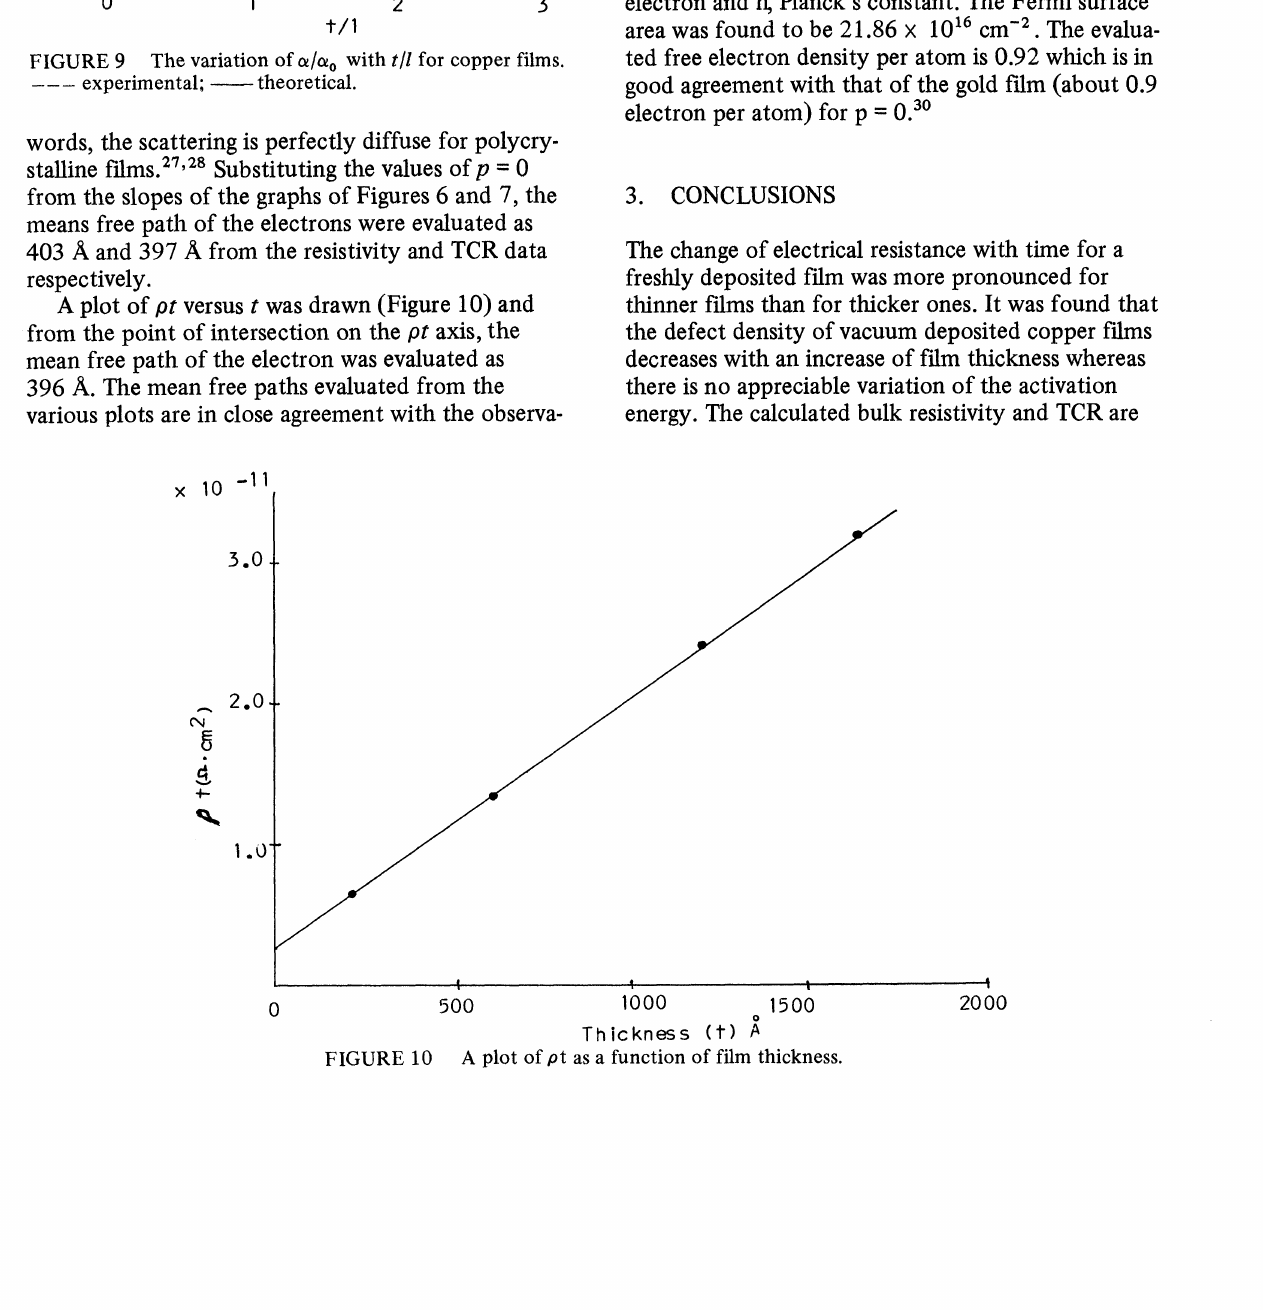
Thickness (t) A plot of tgt as a function of film